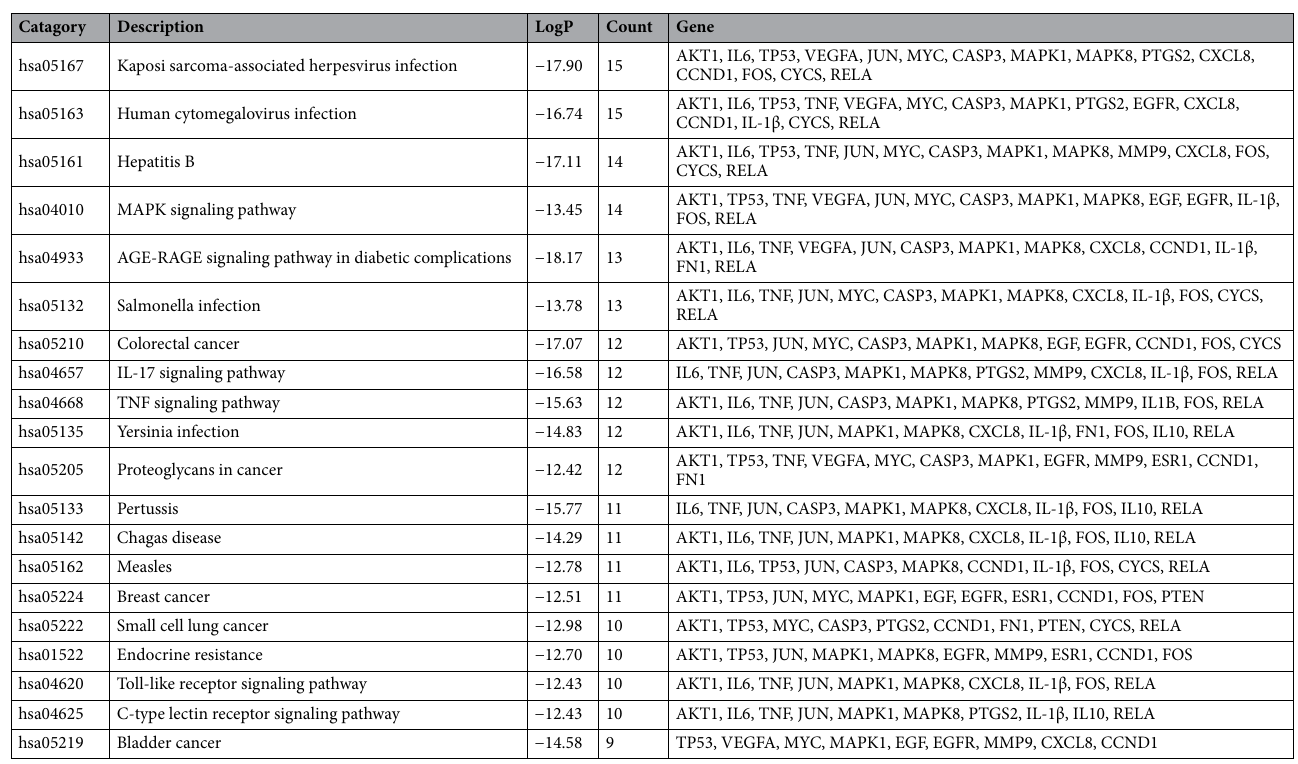
Table 3. Top 20 clusters with their representative enriched